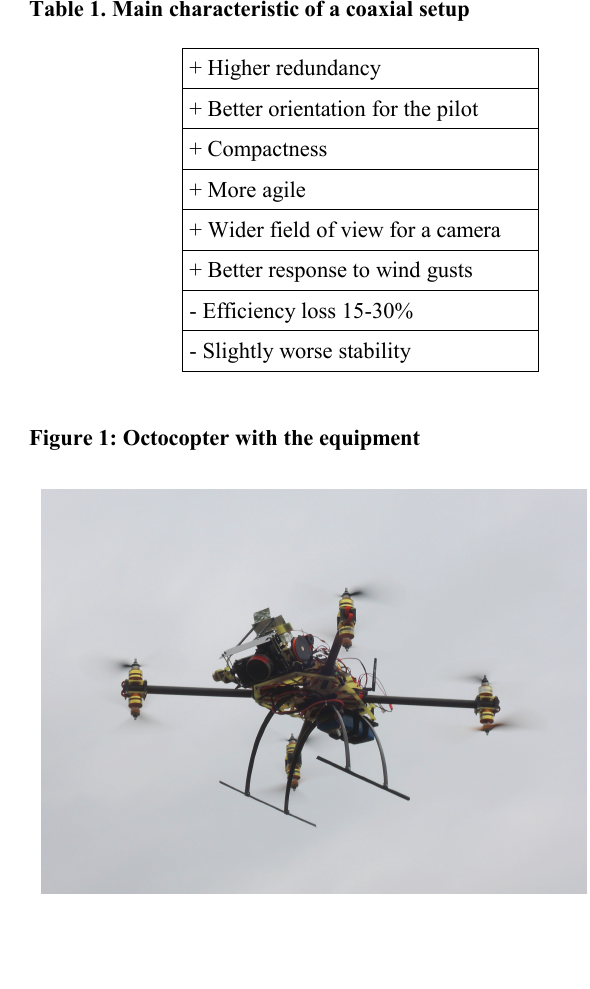
Table 1. Main characteristic of a coaxial setup